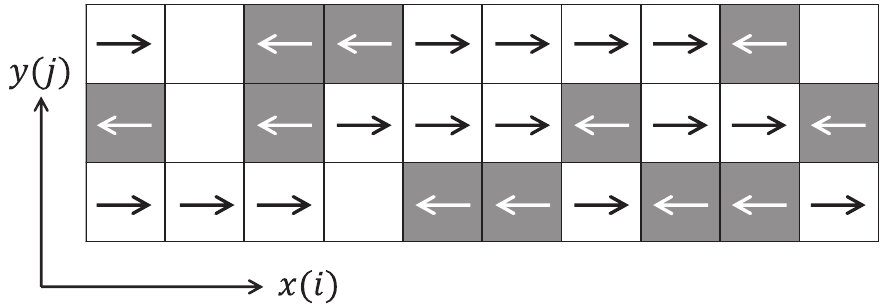
Fig 7. Order parameter. Schematic representation used for the calculation of the order parameter. Each cell indicates a positive or a negative x -velocity.